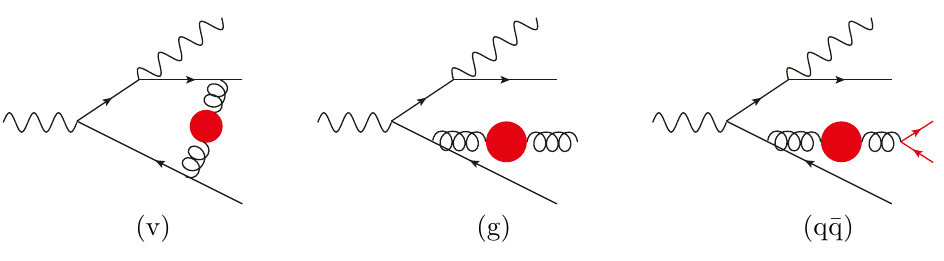
Figure 1 . A sample of the radiative corrections that need to be included in order to compute the all-order α ( α ) n corrections to the process γ ∗ → d ¯ dγ s s n f